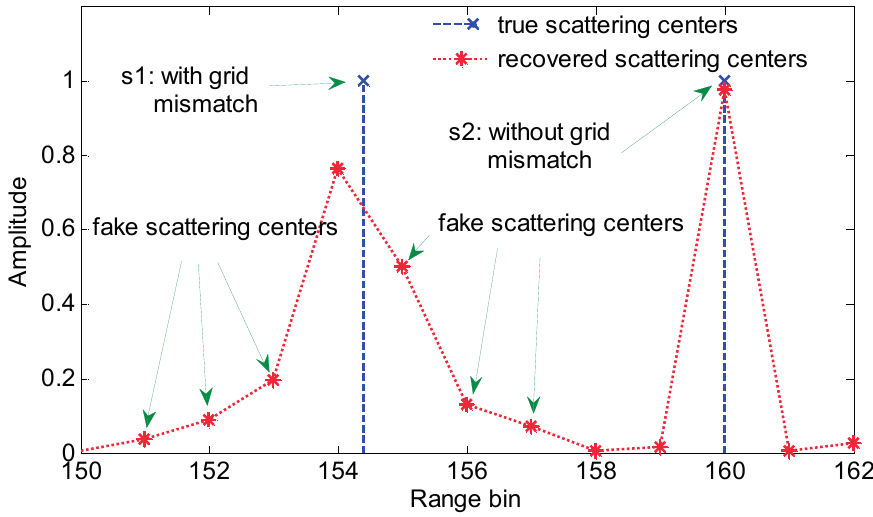
Figure 2. Reconstructed result via SR algorithm of two scattering centers.